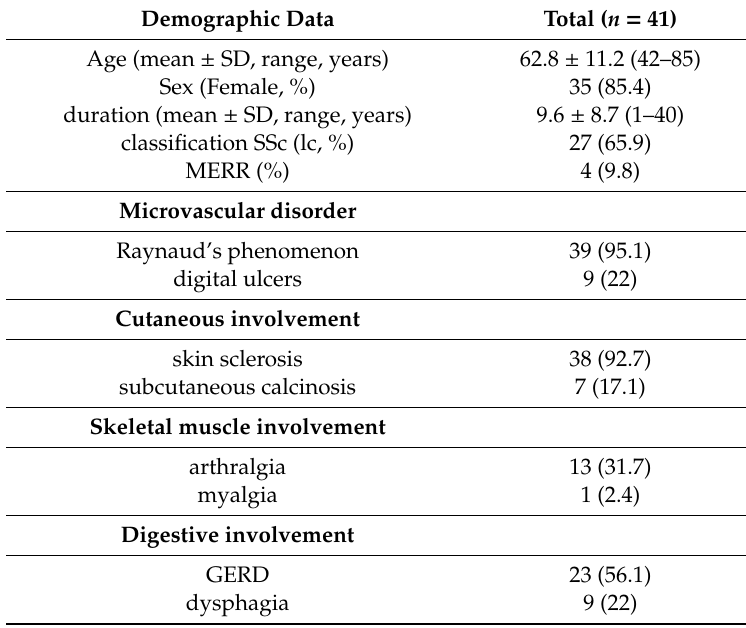
Table 1. Demographic data of all systemic sclerosis (SSc) patients. Systemic and maxillofacial involvement and antibodies; number (%). When the total number was less than 41, it was described as number / total